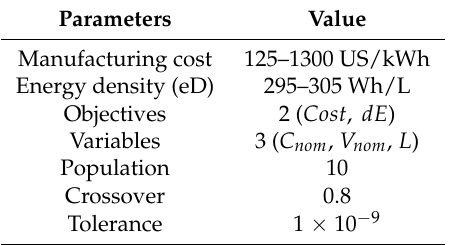
Table 1. Multi-objective genetic algorithm parameters.